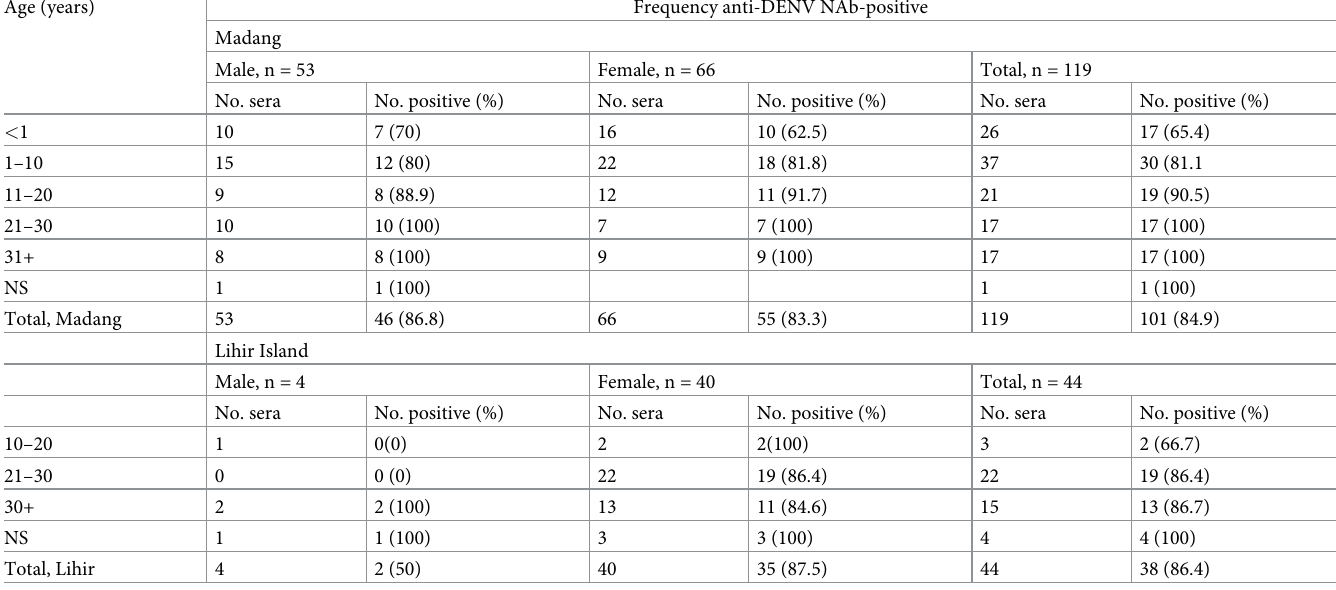
Table 6. Age and sex distribution for seropositive